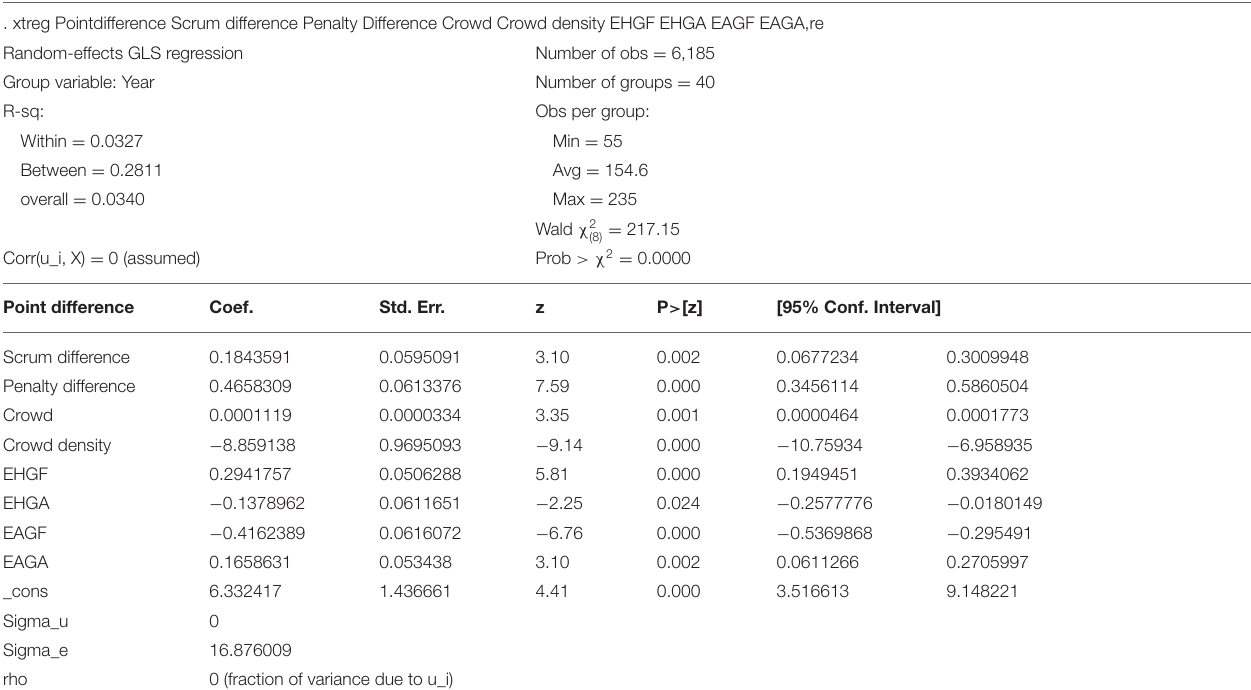
TABLE 3 | Random effects regression with points difference as the dependent